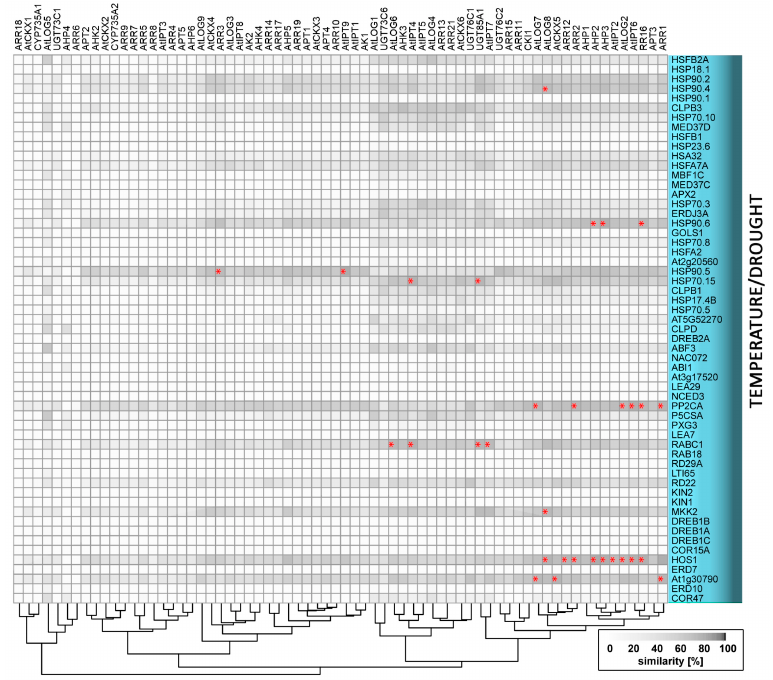
Figure 4. Similarity of expression patterns of genes related to temperature/drought stress and genes involved in cytokinin metabolism or signalling. Asterisks indicate profile similarities >85%. The heatmap was generated using R software and available data from Araport [33].